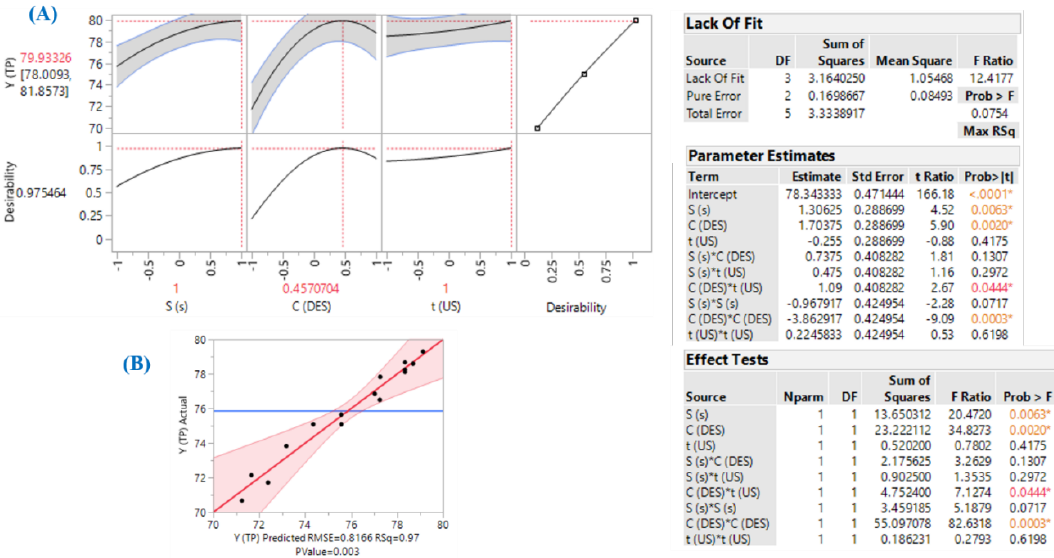
Figure 4. Statistics associated with model fitting, performed by implementing response surface methodology. ( A ), Desirability function; and ( B ), actual-by-predicted plot. Inset tables (lack-of-fit, parameter estimates and effect test) illustrate the effect of independent (process) variables on the response. Asterisk ( * ) on values in the “parameter estimates” and “test effects” inset tables signify statistically significant values (at least at a 95% significance level).